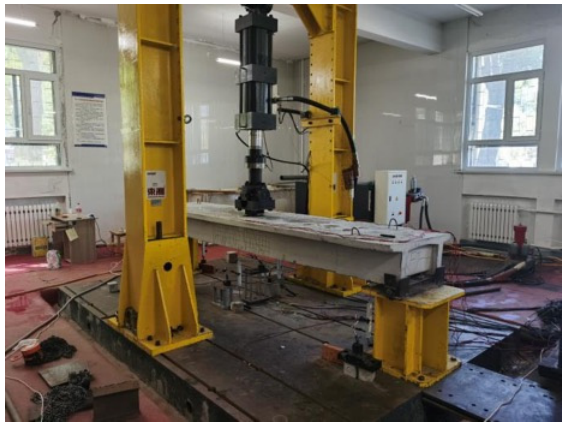
Figure 6. The loading conditions at the testing site.